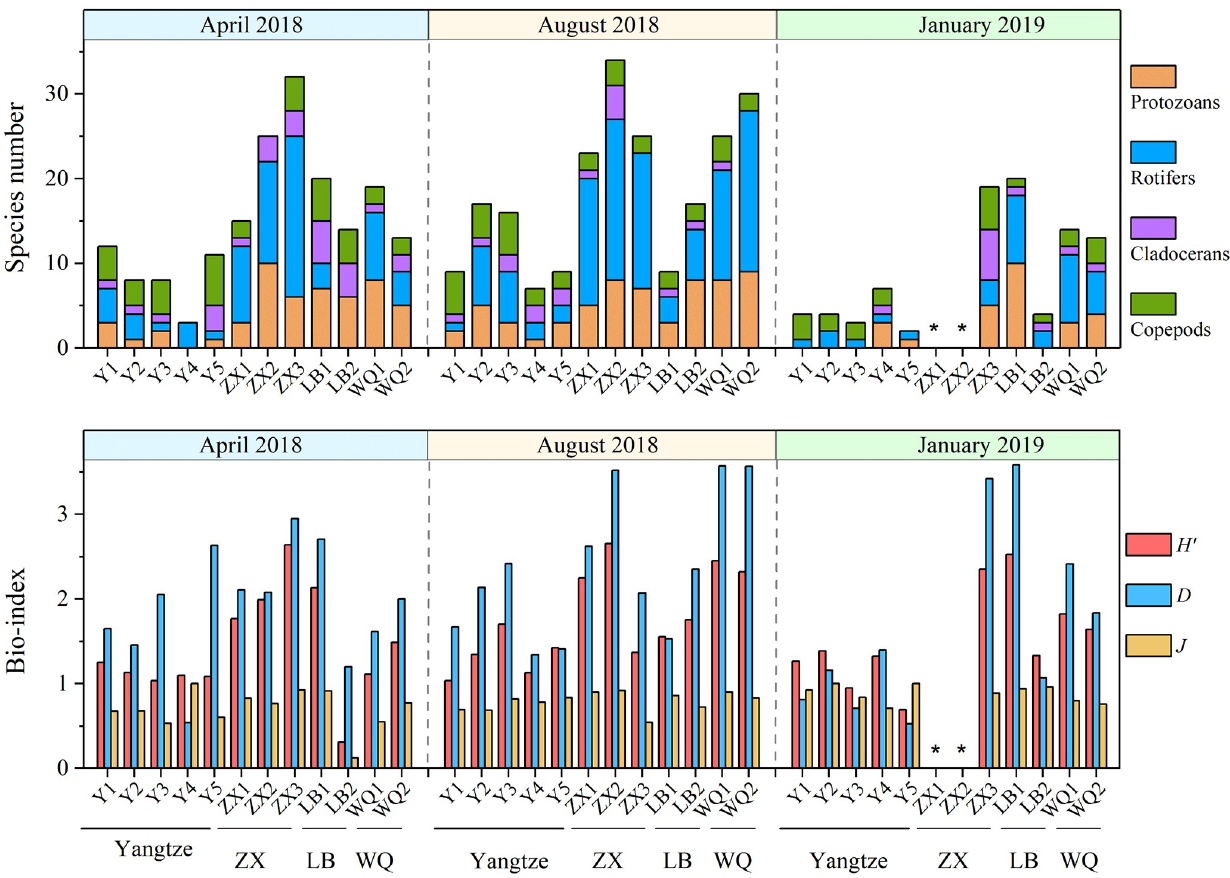
Fig 6. Zooplankton species number and bio-index in the Yangtze River and its tributaries in Wanzhou. Note: � not detected.